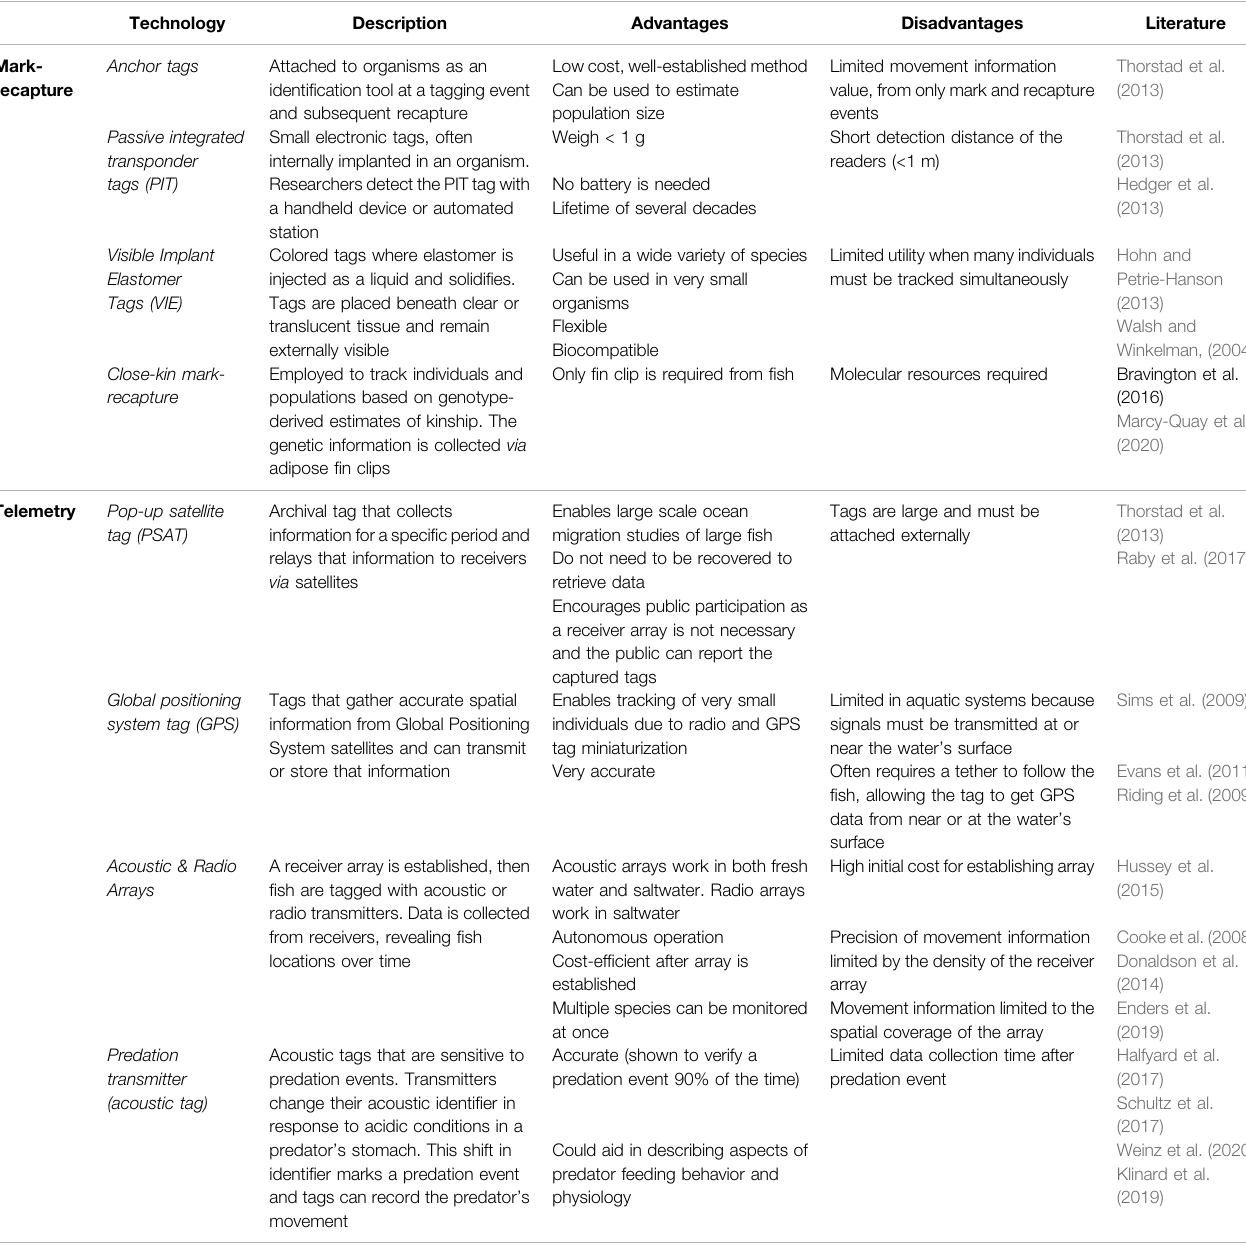
TABLE1| Methodsforstudyingmovementinfreshwater fi shes.Methodsarebroadlyclassi fi edintomark-recaptureandtelemetry-basedapproaches.Technologyprovides the commonly used name for each method and description provides a brief summary of how the method operates. Advantages, disadvantages, and representative literature for each method are also